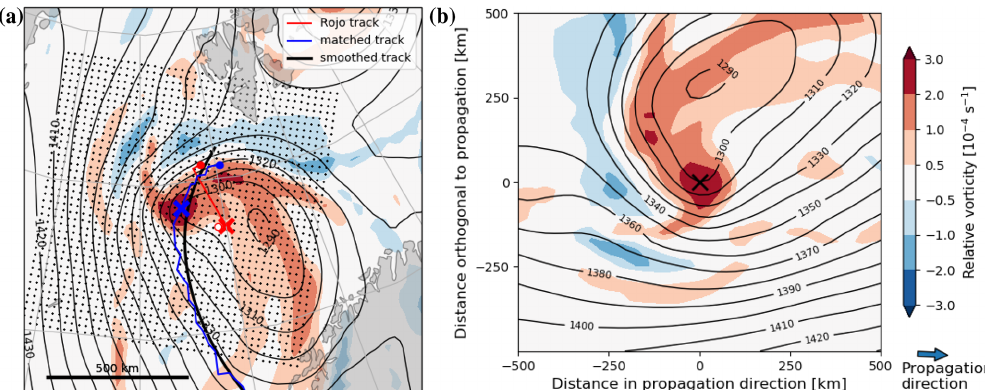
Figure 1. Exemplary depiction of deriving the PL-centred analysis. (a) Relative vorticity at 850hPa (shading) and geopotential height at 850hPa (contours, spacing 10m) for 20 March 2001 01:00UTC. The track of polar-low number 10 from the Rojo list is shown in red and the matched track is depicted in blue. The locations at the selected time are indicated by “x”. The smoothed track is depicted in black, and the propagation direction of the PL at the selected time is southward. (b) Same fields as for (a) in the polar-low centred domain, constructed such that the polar-low centre is in the middle (“x”) and the propagation direction is towards the